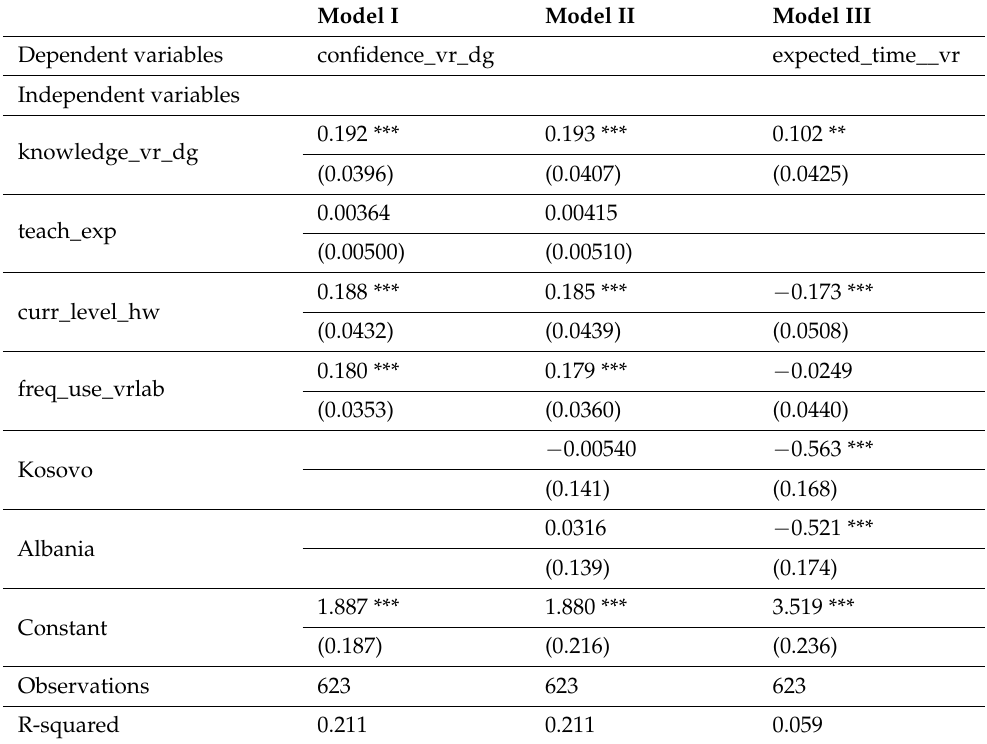
Table 2. Statistical analysis for academic staff. Robust standard errors are in parentheses. *** p < 0.01 ** p <